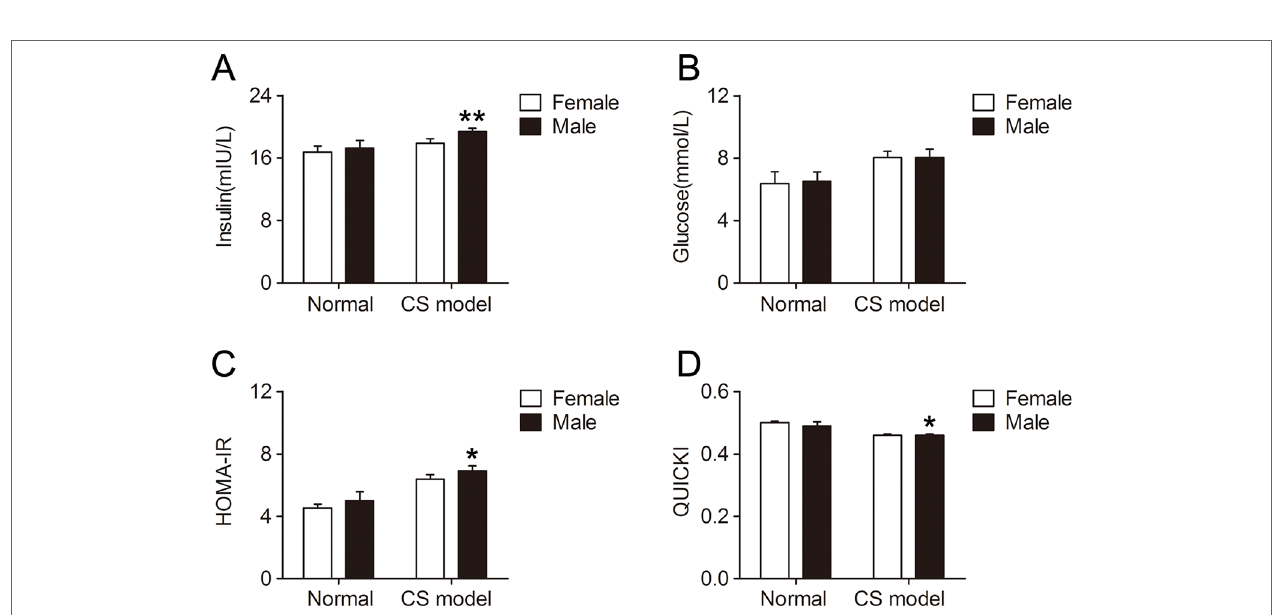
FIgURE 6 | Gender difference of insulin sensitivity in mice with crush syndrome (CS). Blood samples of mice with CS were collected at 6 h after decompression. Female CS models exhibited lower serum insulin level (A) and homeostasis model assessment of insulin resistance index (C) , and higher quantitative insulin sensitivity check index (D) than that in male. Serum glucose level was not affected by gender in CS models (B) . N = 6 per group. * P < 0.05, ** P < 0.01 vs. female.